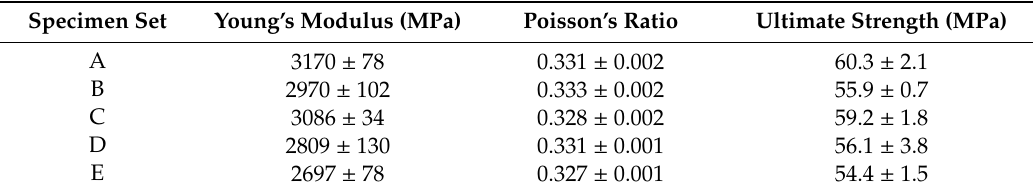
Table 7. Mechanical properties for the 3D printed PLA material.